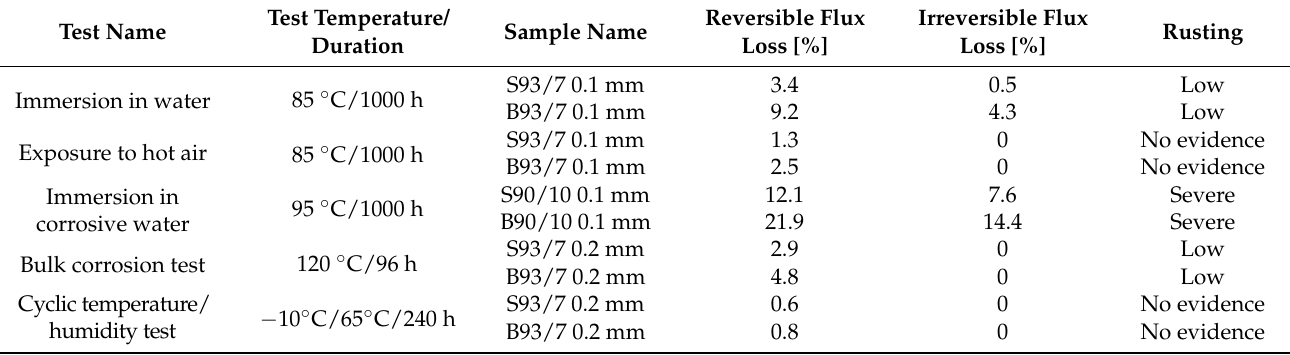
Table 10. Overview of environmental testing and flux loss due to